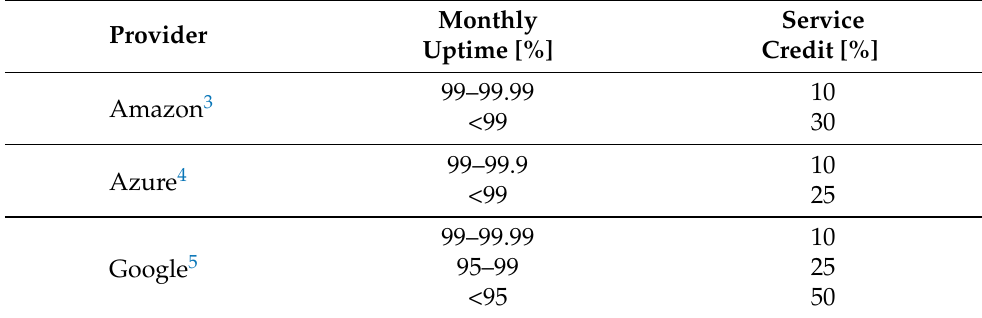
Table 1. Refunds as a percentage of the service